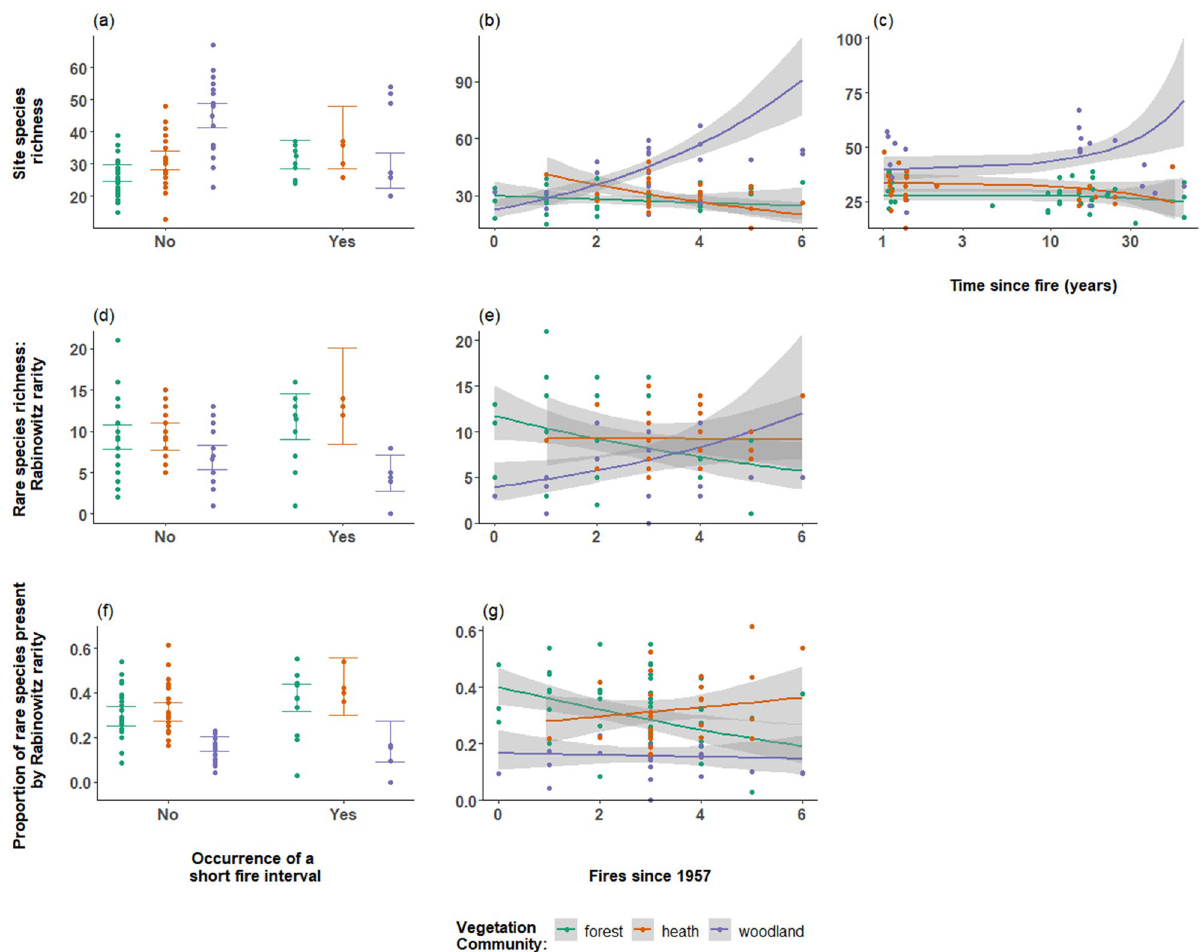
Figure 1. Associations between the occurrence of a short interval, the number of fires since 1957 (fire frequency) and time since fire, with site species richness ( a – c ); Rabinowitz rare species richness with the occurrence of a short interval and the number of fires since 1957 ( d , e ); and the proportion of Rabinowitz rare species present ( f , g ) across the three major vegetation communities in Booderee National Park; forest (green), heath (orange), and woodland (purple). Predicted values are from the top-ranked model and 95% prediction confidence intervals are shown. Closed circles show raw site vegetation data for each vegetation community. For time since fire ( c ), the log of time since fire was used for analyses but the predicted values are shown on the original scale of time since fire in communities (P < 0.001, Fig. 1a.). Species richness was significantly positively associated with fire frequency and time since fire in woodland communities (P < 0.001 Fig. 1b.; P < 0.001, Fig. 1c.). The occurrence of a short fire interval was positively associated with the species richness in forest sites (P = 0.045, Fig. 1a). We found no signifi- cant associations between species richness and the fire regime variables in heath communities. The most strongly reported model for rare species richness by abundance and distribution included only vegetation type. Rare species classified by their abundance and distribution showed no associations between rare species richness and the fire regime variables examined. With Rabinowitz’s measure of rarity, the most strongly supported model included fire frequency and the occurrence of a short fire interval interacting with vegetation type. We found that in woodland communities, rare species richness was significantly negatively associated with the occurrence of a short fire interval when species were classified with Rabinowitz’s measure of rarity (P = 0.001, Fig. 1d), but positively associated with fire frequency (P = 0.001, Fig. 1e). In forest communities, Rabinowitz rare species richness was positively associated with the occurrence of a short fire interval (P = 0.010, Fig. 1d), but was negatively associated with fire frequency (P = 0.017, Fig. 1e). Heath communities showed no associations between rare species richness and all fire regime variables examined. The proportion of rare species present in response to fire regimes. With abundance as a measure of rarity, the most strongly supported model included only vegetation type. With distribution as a measure of rarity, the top-ranked model included time since fire (logged) and vegetation type. However, no associations were present between the proportion of rare species present with time since fire across all three vegetation com- munities with the two measures of rarity.